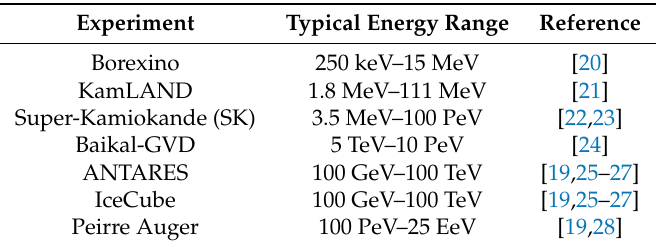
Table 1. Summary of neutrino detectors and references for their searches.